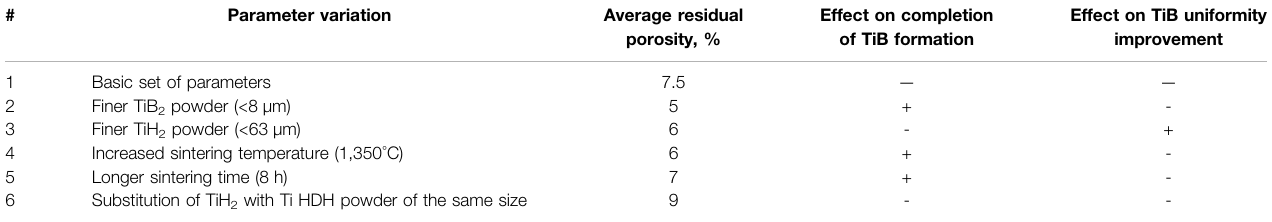
TABLE 1 | Microstructural characteristics of Ti/8.4% TiB composites produced with various press-and-sinter BEPM